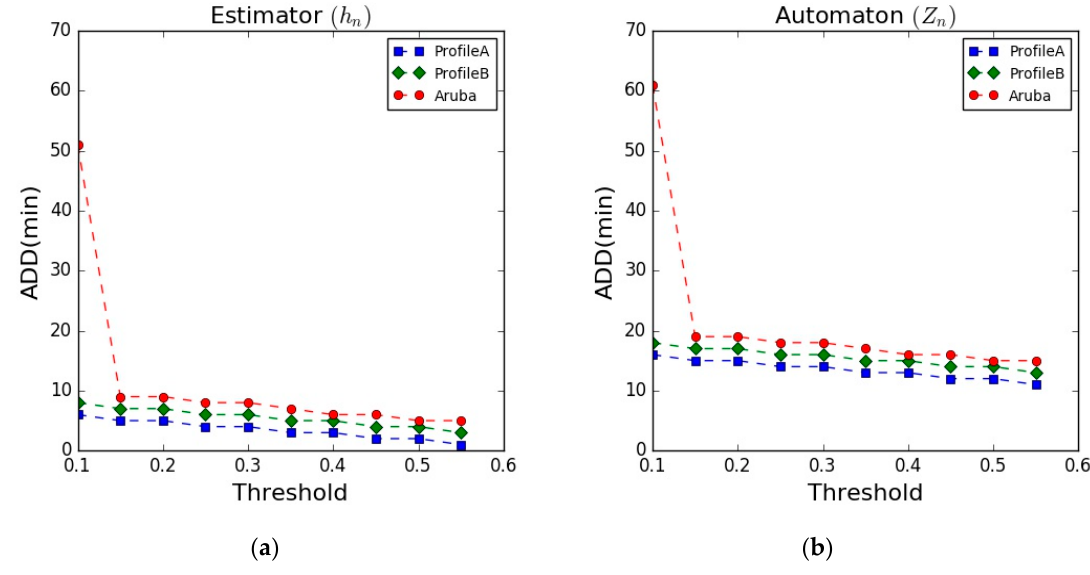
Figure 9. Anomaly Detection Delay (ADD. ( a ) Estimator results; ( b ) Automaton results.